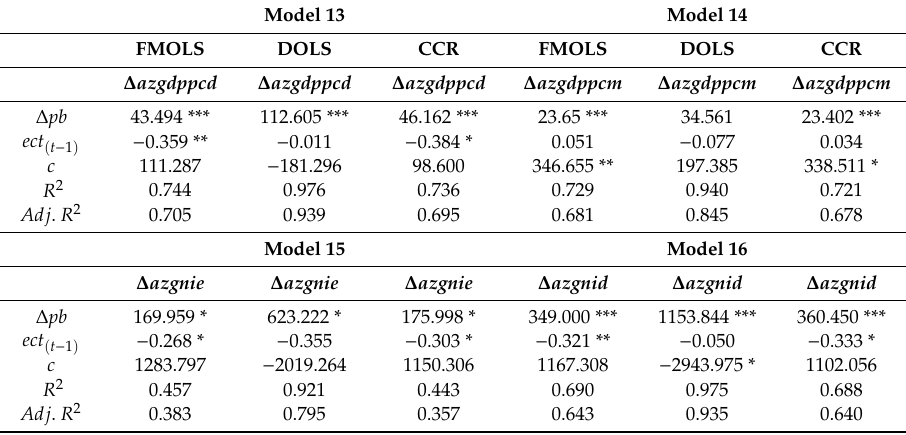
Table 11. The influence of oil price on macroeconomic indicators